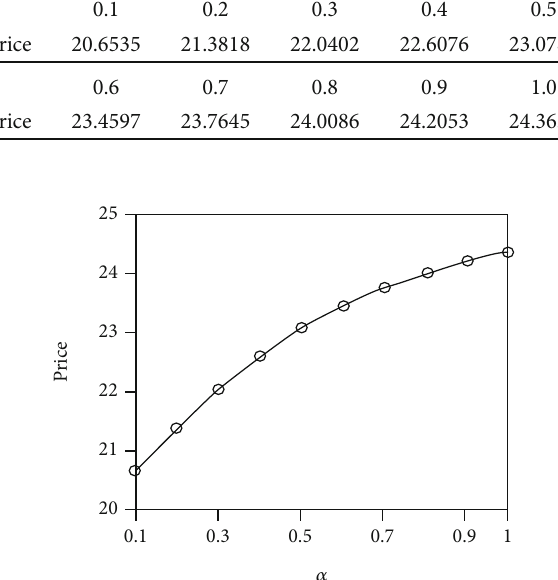
Figure 8: Plot of option prices with respect to α